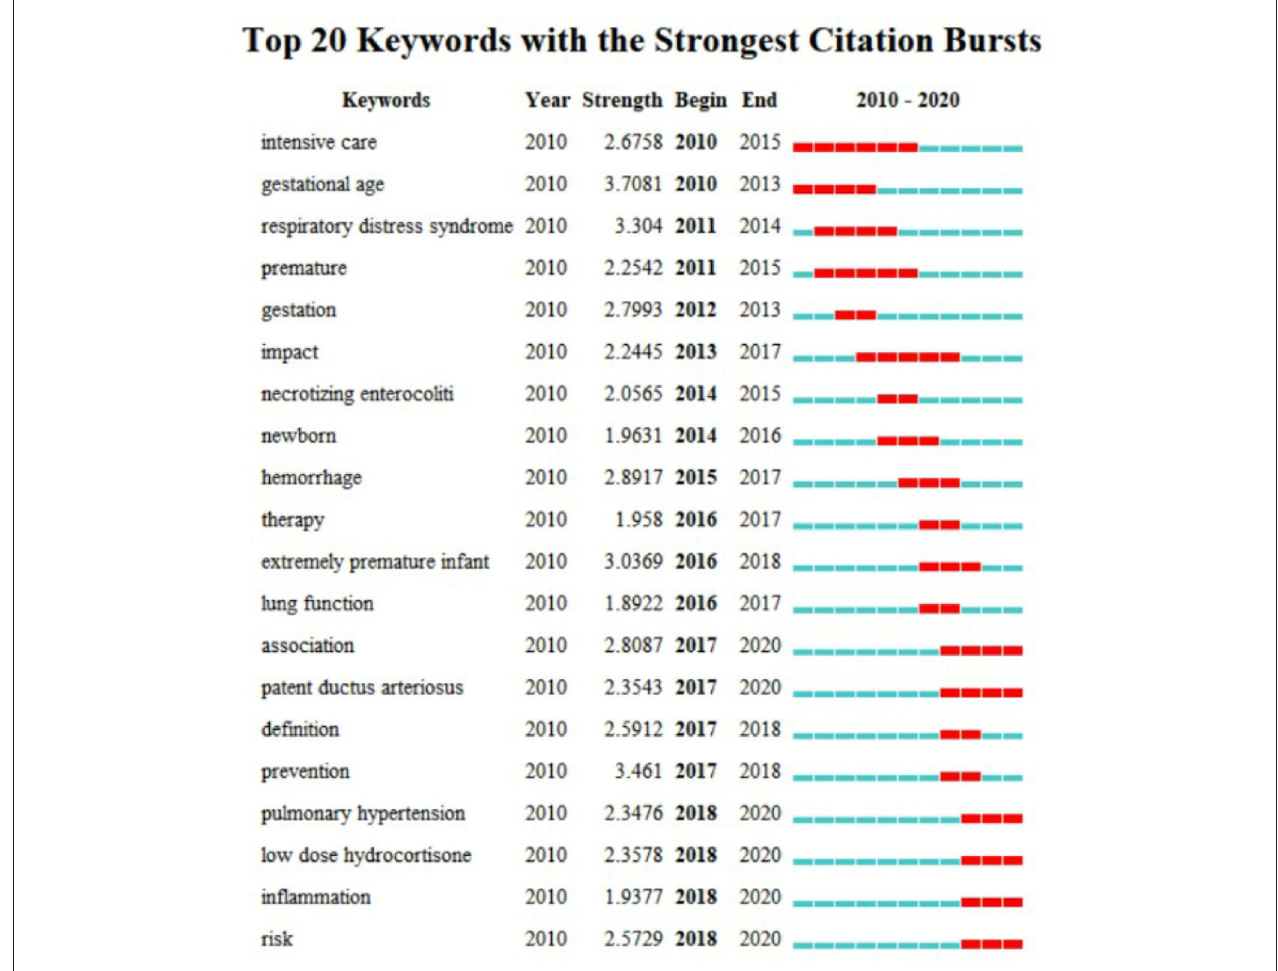
FIGURE 6 | Burstness map of keywords on BPD in extremely pre-mature